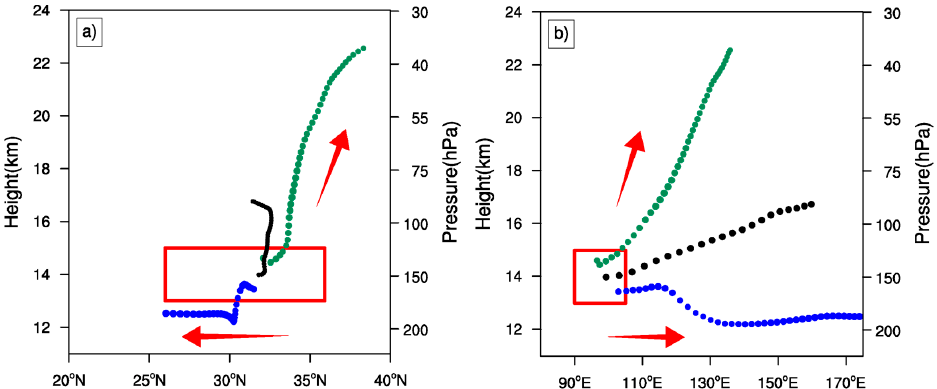
Figure 6. As in Figure 5 but along ( a ) a meridional cross section and ( b ) a zonal cross section.